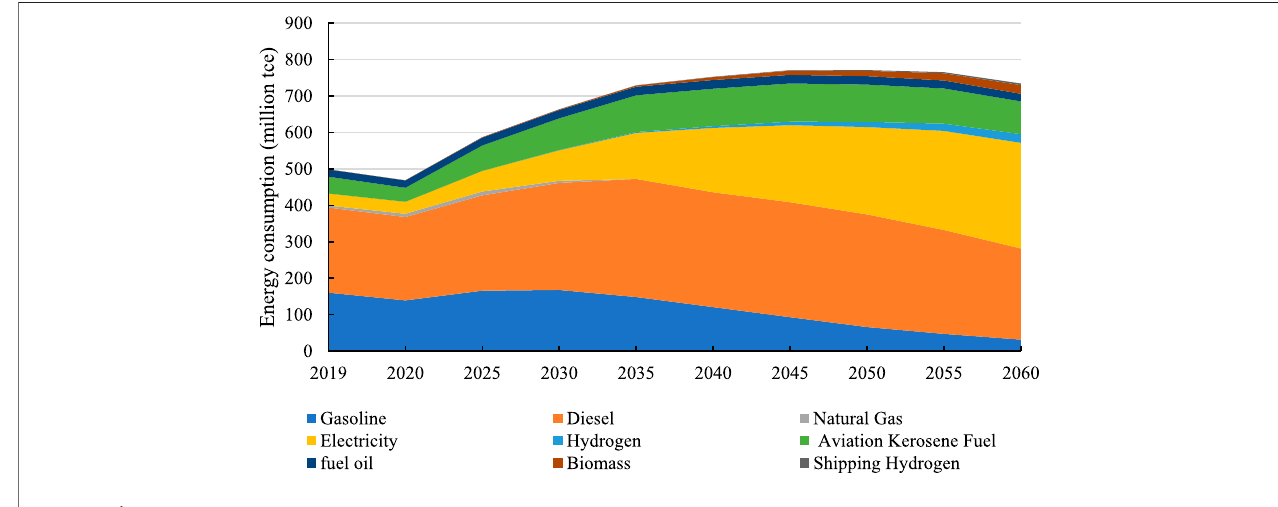
FIGURE 7 | Different fuel consumption trends under the baseline scenario.